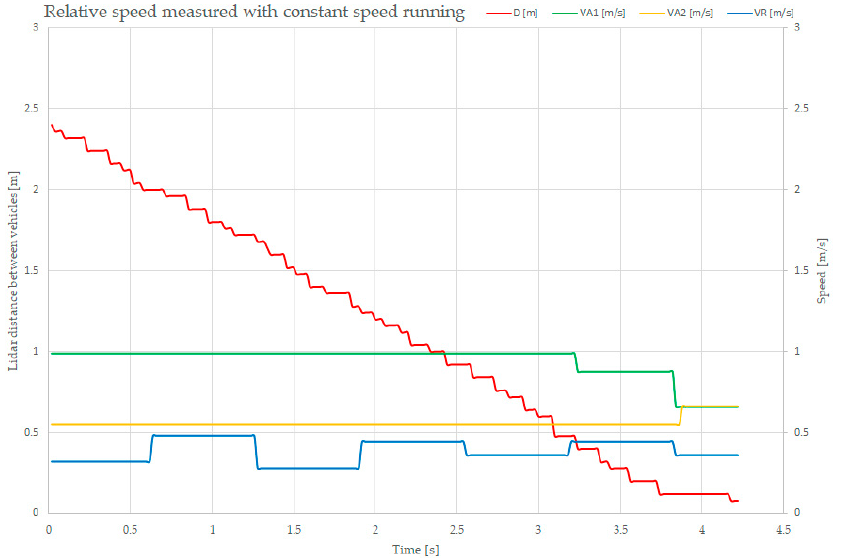
Figure 19. Plot of the relative distance and speed measurement at constant running speeds. The red-lined graph is the measured and reported distance between the two vehicles, descending from 2.4 m down to 0.1 m, meaning that the two vehicles collided. The green- lined graph shows the on-board measurements of the SLAVE#1 speed (1 m/s), and the yellow one represents the on-board measurements of the SLAVE#2 speed (0.66 m/s). The blue speed is the computed and reported relative speed between the two vehicles. For stability reasons, the speed is integrated over a 0.6 s time slot. In order to improve this speed measurement, some software-based refinement procedures must be implemented.